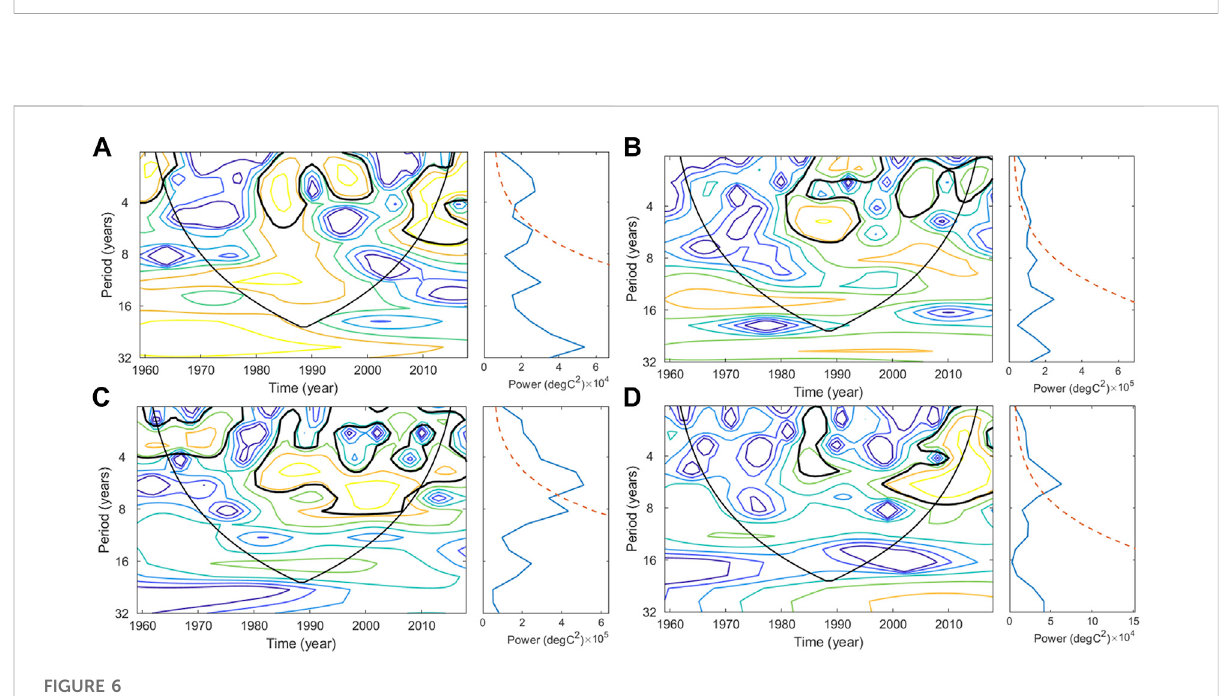
FIGURE 6 Wavelet power spectrum and global wavelet spectrum of TCP in the four subregions between 1959 and 2018: (A) northeastern China, (B) eastern China, (C) southern China, and (D) inland